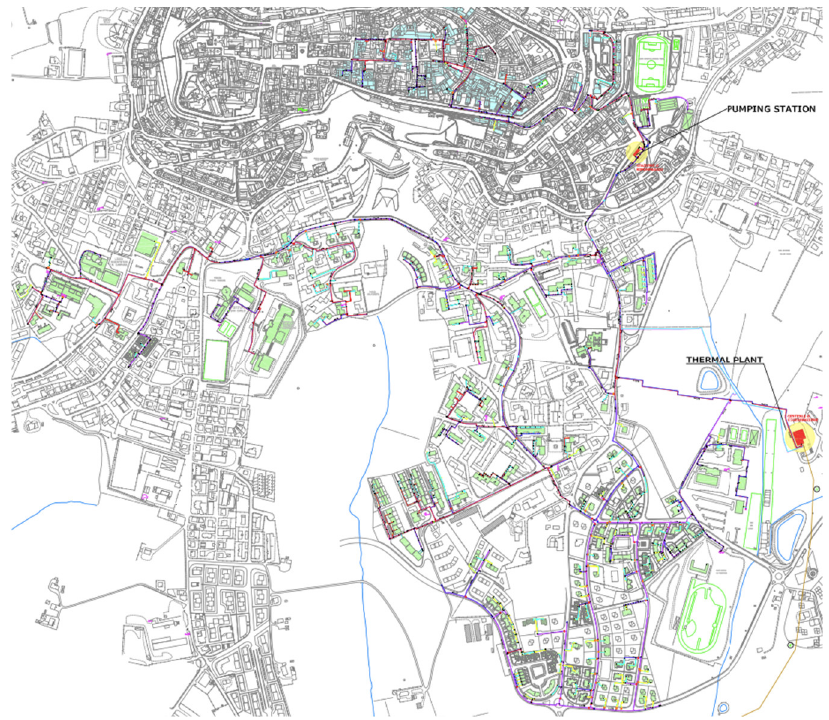
Figure 4. Overview of the DH network (both thermal power plant and pumping station are high- lighted in yellow). Table 2. Thermal losses in the DH network (year